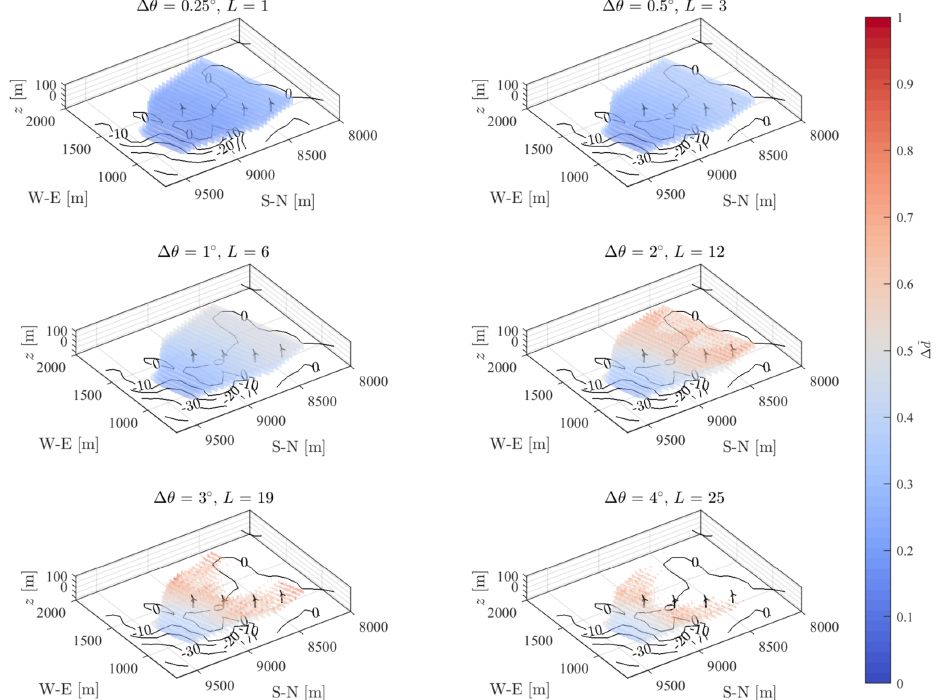
Figure 6. Random data spacing, (cid:49) ˜ d , for six volumetric scans with different angular resolution and σ = 1 / 4. Points violating the Petersen– Middleton constraint ( (cid:49) ˜ d > 1) are not displayed.